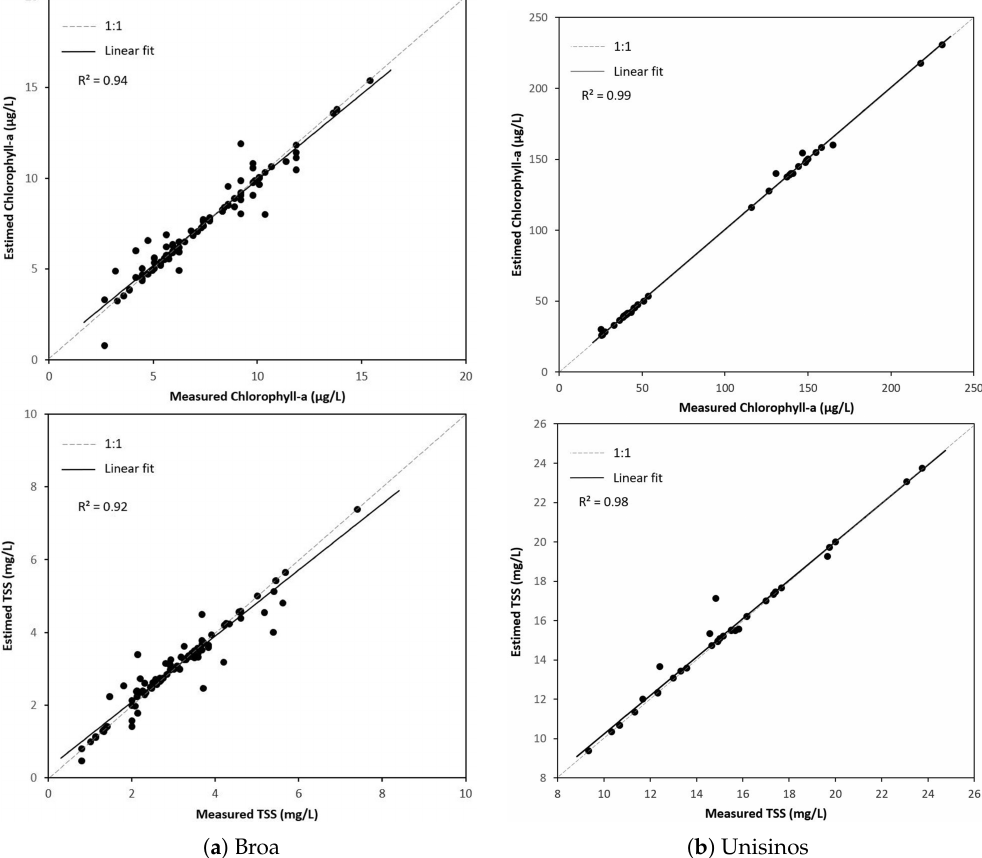
Figure 7. Comparison between field measurements with the random forest